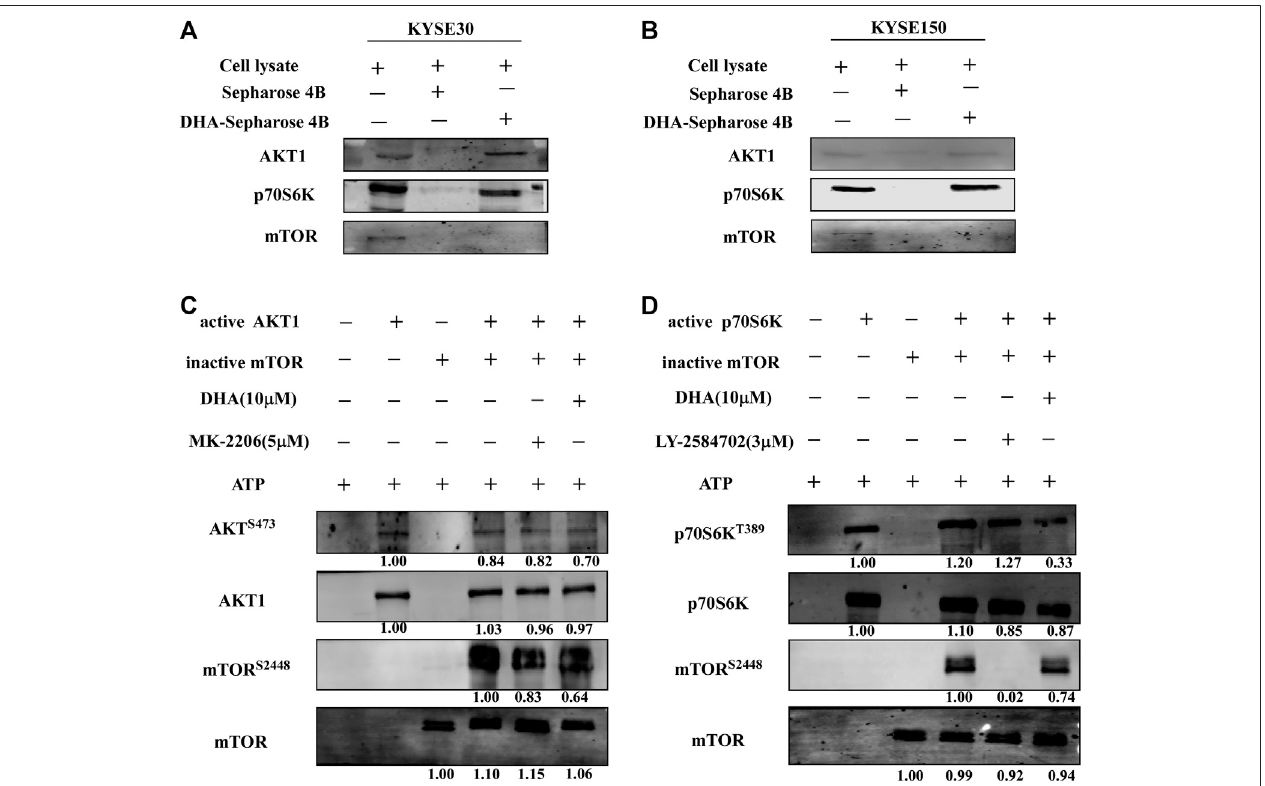
FIGURE4| DHAaffectsmTORsignaling pathwayinESCCcellsbytargeting AKT1andp70S6K. (A) DHAdirectlybound toAKT1andp70S6K inKYSE30cells (B) DHA directly bound to AKT1 and p70S6K in KYSE150 cells. ESCC cell lysates (500 μ g) were incubated with DHA-conjugated Sepharose 4B beads or Sepharose 4B beads alone. The pulled-down proteins were analyzed using western blot analysis. (C) DHA attenuated the phosphorylation of mTOR by inhibiting the kinase activity of AKT1 (D) DHA attenuated the phosphorylation of mTOR by inhibiting the kinase activity of p70S6K.